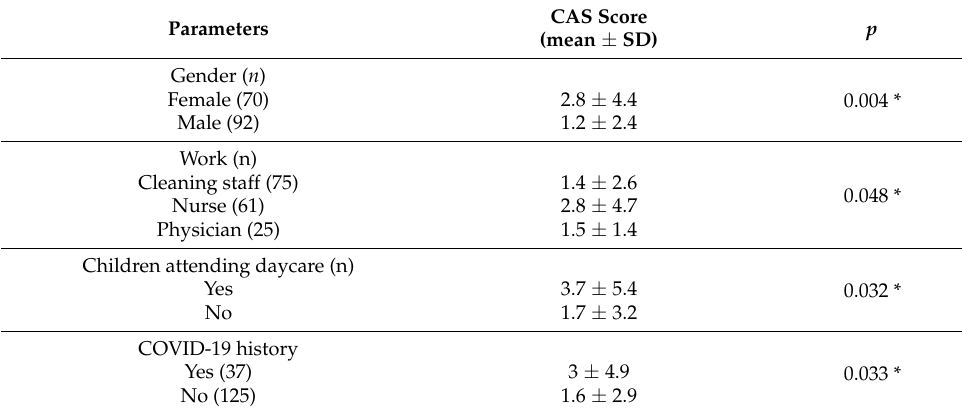
Table 2. Parameters affecting CAS scores.